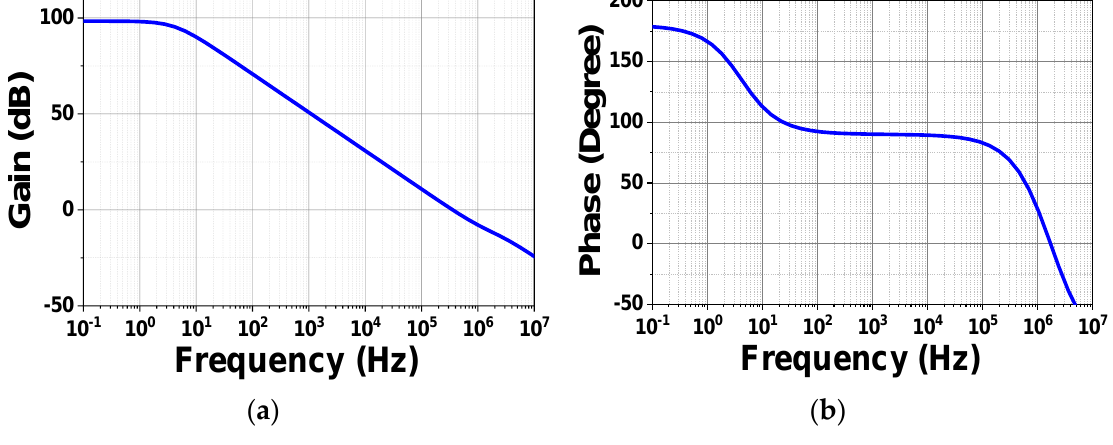
Figure 9. Open-loop simulation results for gain ( a ) and phase ( b ) versus frequency of main path amplifier with active A-OCL.